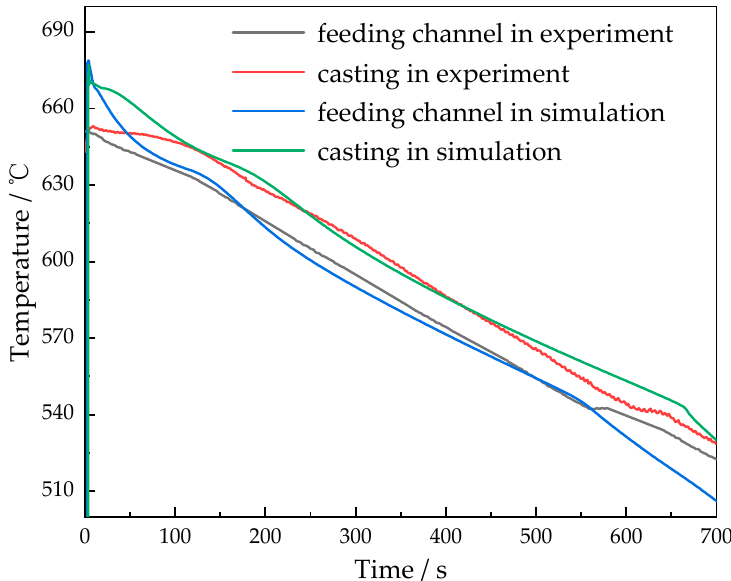
Figure 5. Comparison of experimental and numerical temperatures at the center of the casting and